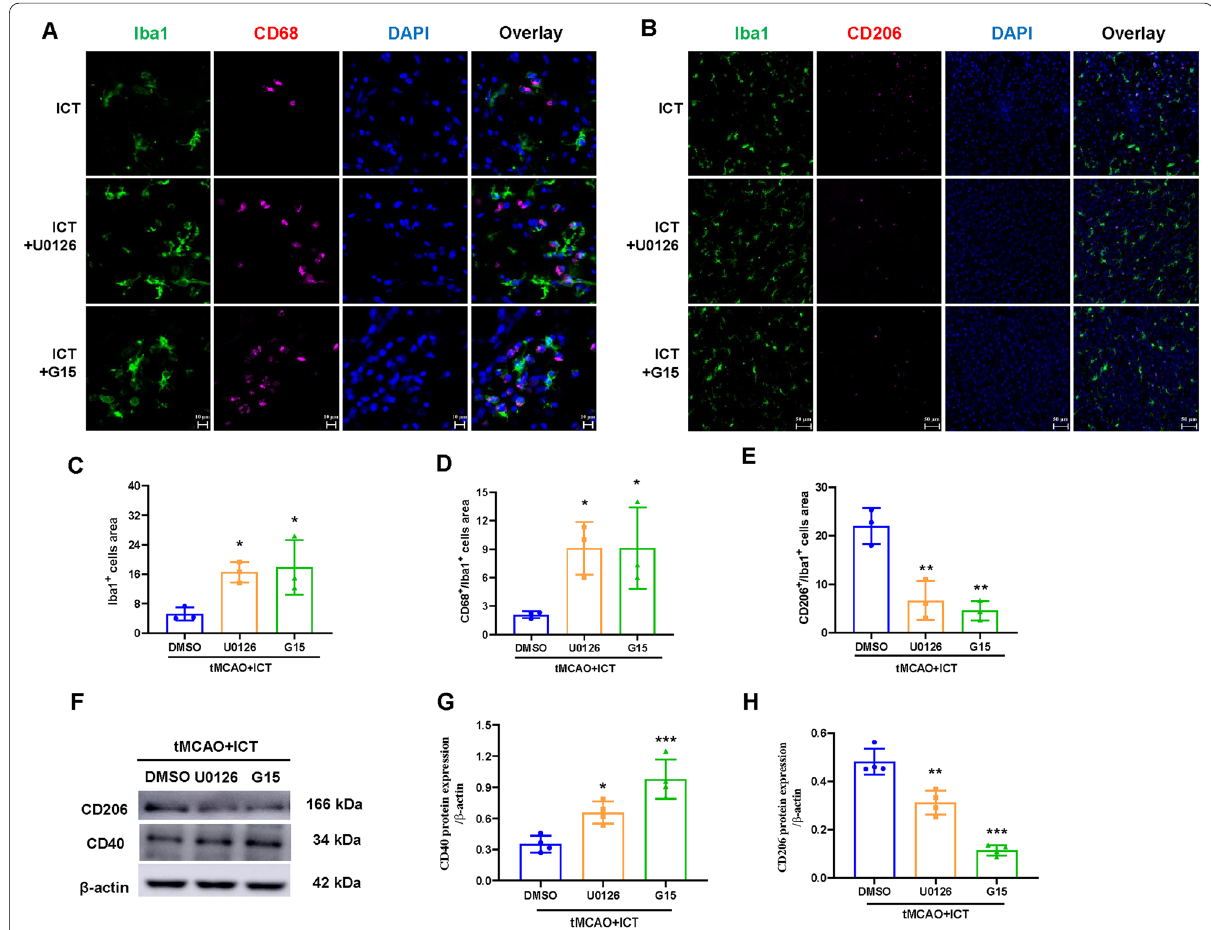
Fig. 7 U0126 and G15 reversed the effect of ICT on the phenotypic polarization of microglia M1/M2 in tMCAO rats. A and B Representative immunofluorescent images of microglia polarization in the ischemic penumbra. The immunofluorescence staining of microglia with anti-CD68 (magenta), CD206 (magenta), and Iba1 (green) antibody. The nucleus was stained by DAPI; A : scale bar Immunofluorescence quantitation (n * P < 0.05, ** P < 0.01, **** P < 0.0001, compared with tMCAO